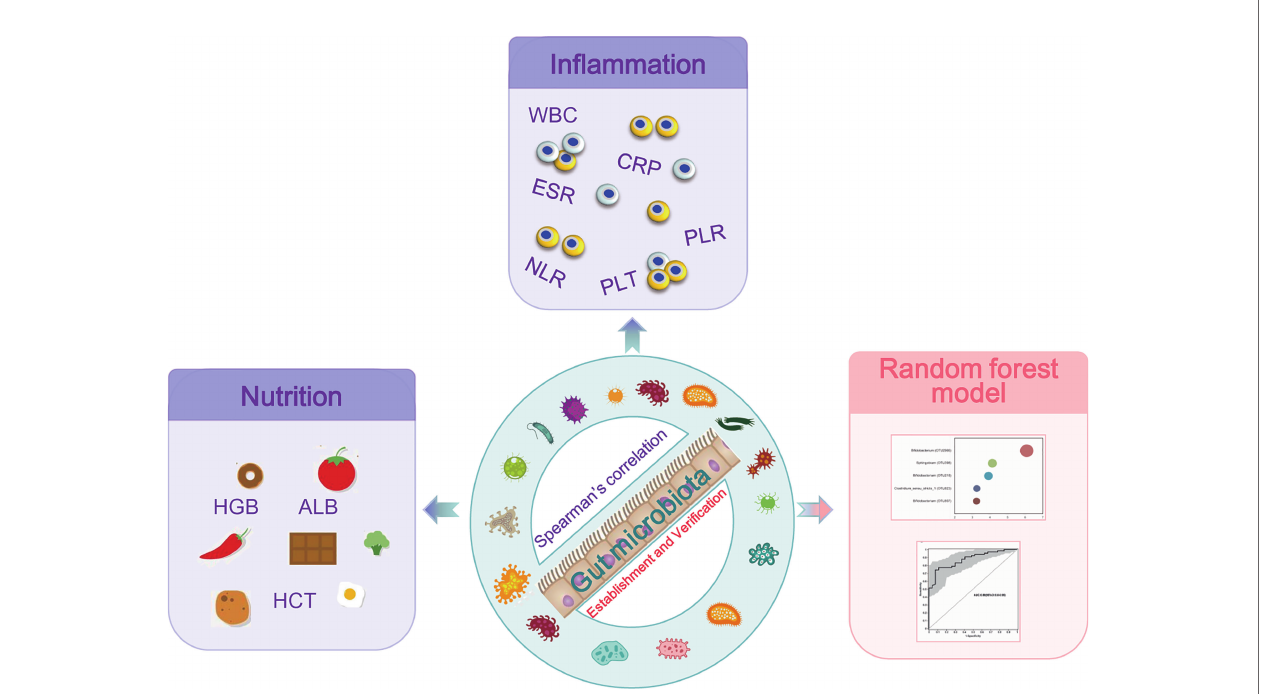
FIGURE 6 | Study design: discovery cohort enrolled 66 newly diagnosed young IBD patients and 27 healthy controls for gut microbiome 16S rRNAseq. The pro fi les of the microbiome in PIBD and its relationship with the disease activity and nutrition status were analyzed. Intestinal microecological machine learning was constructed to generate a PIBD diagnosis tool using microbiome data. Subsequently, 14 patients with IBD and 48 patients with IBS were collected as a validation cohort for the evaluation of the diagnostic